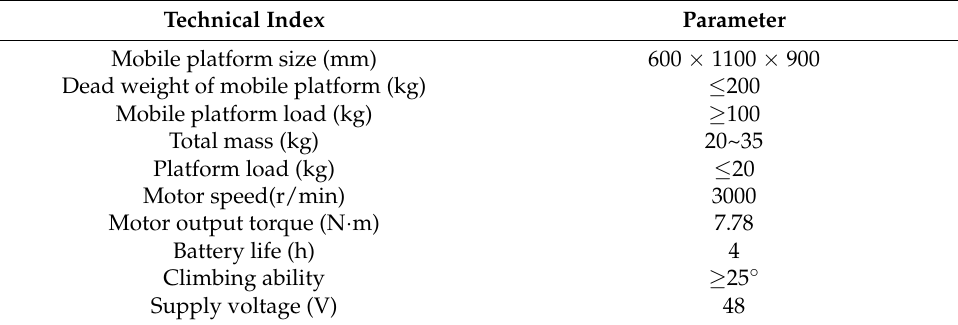
Table 2. Main technical parameters of the mechanism.